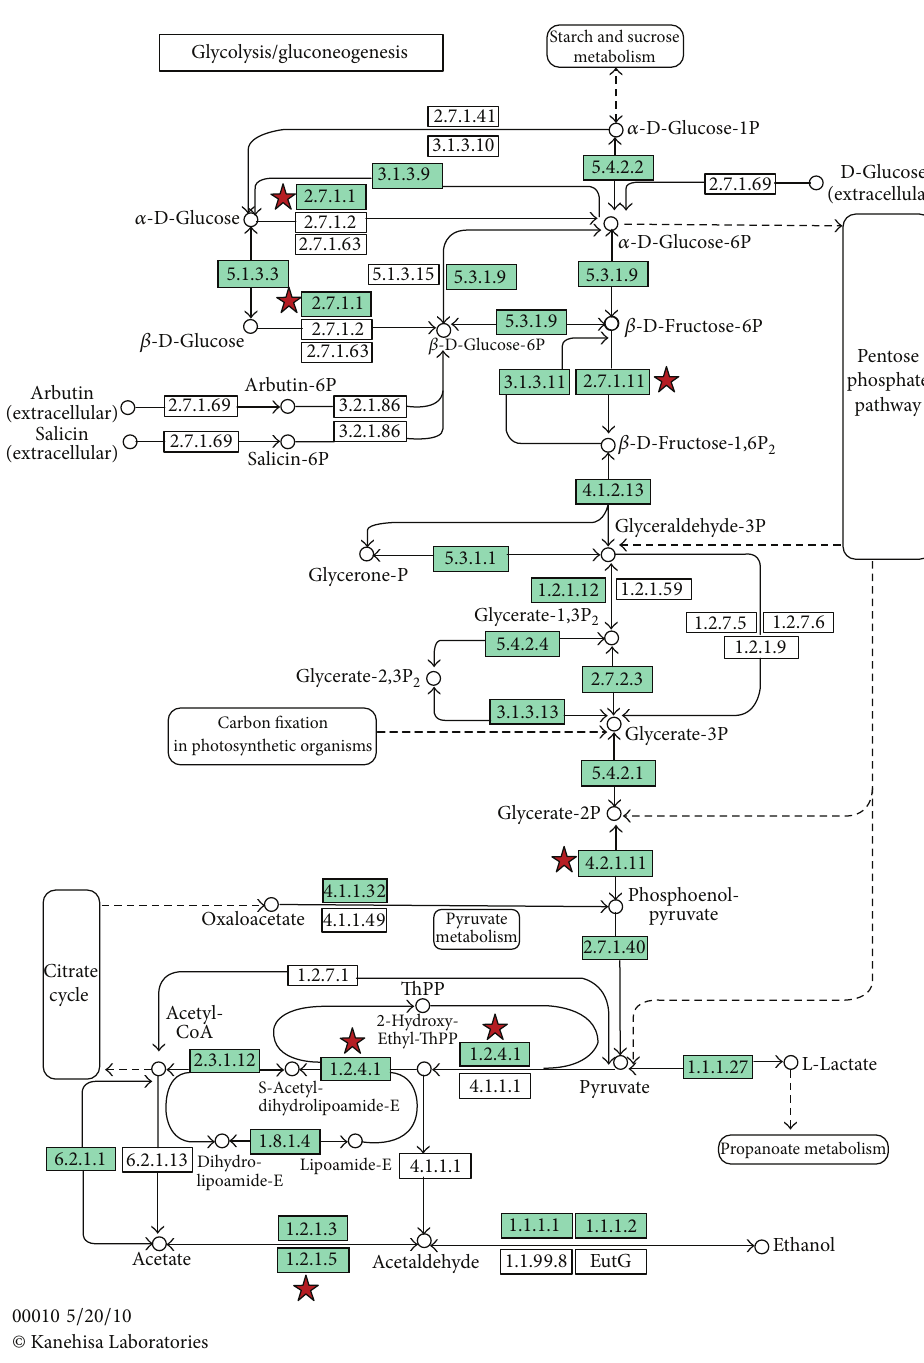
Figure 2: Pathway information of glycolysis/gluconeogenesis. Green boxes denote signaling pathway protein. Red stars mark the genes of differential expression including upregulated and downregulated genes: box 2.7.1.1 for hexokinase-1 and hexokinase-2, box 2.7.1.11 for phosphofructokinase (muscle a), box 4.2.1.11 for enolase-3 (beta, muscle), box 1.2.4.1 for pyruvate dehydrogenase (lipoamide) alpha-1a, and box 1.2.1.5 for aldehyde dehydrogenase-3 family (member D1). Figure 2 was formed from all differentially expressed genes that were analysed using DAVID Bioinformatics Resources 6.7